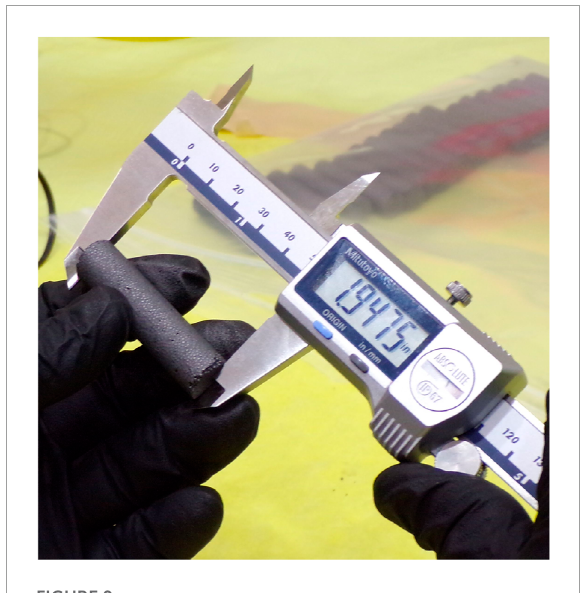
FIGURE 9 Photo of a pellet from the CNPS experiment being measured.